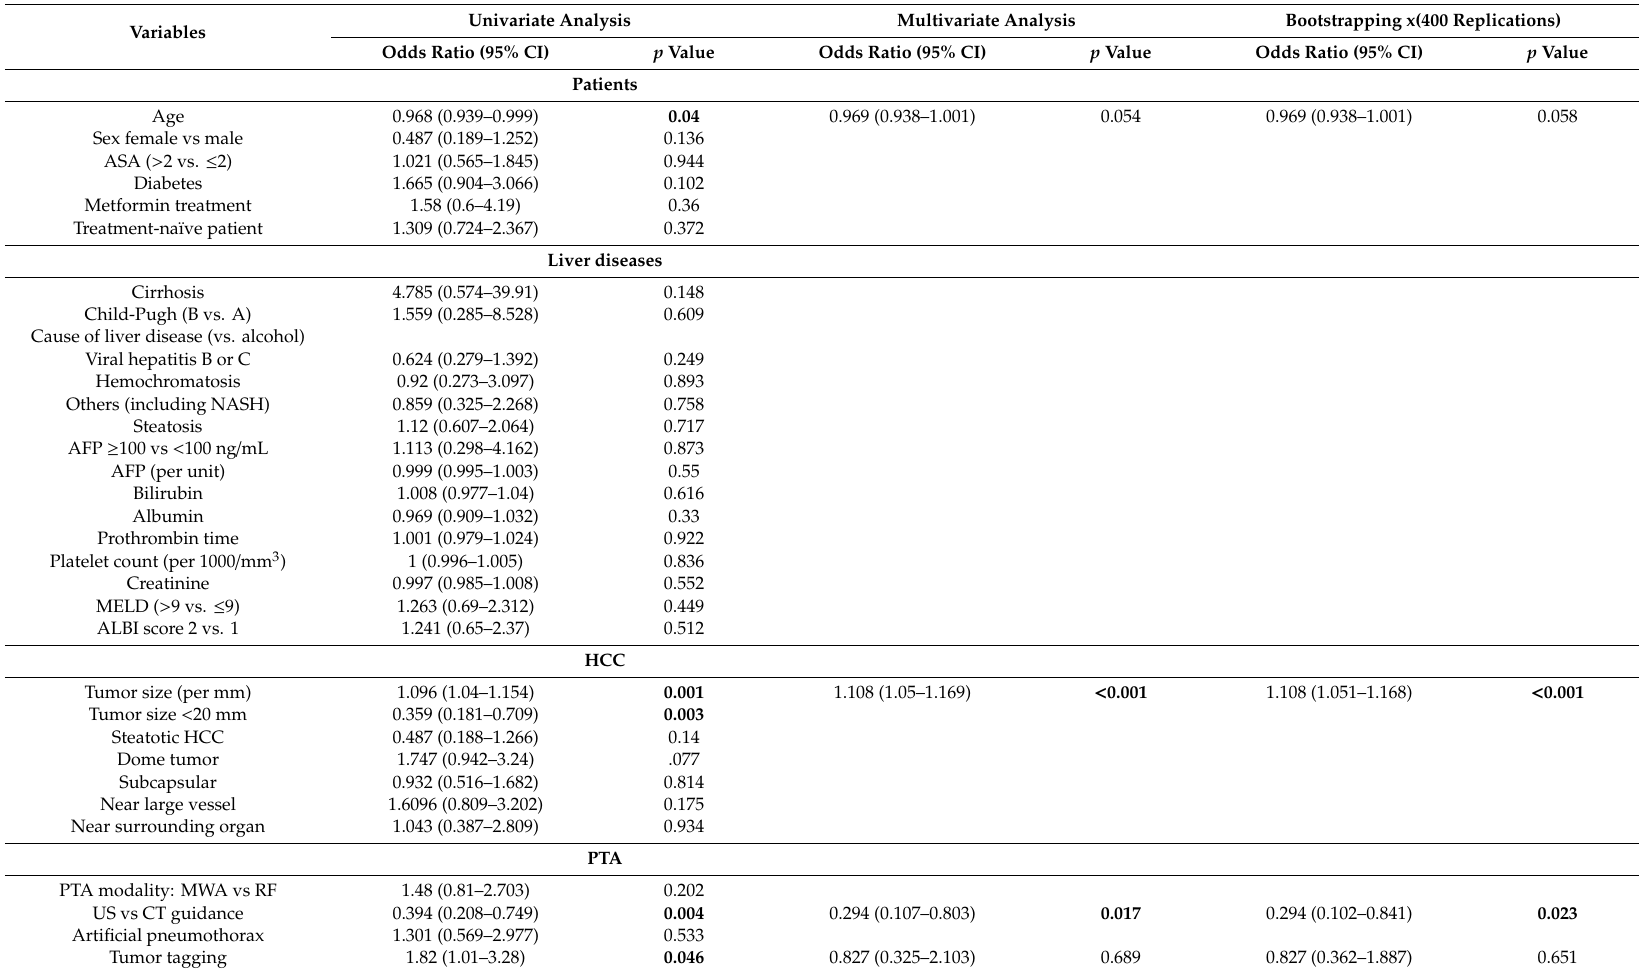
Table 2. Logistic regression analysis (generalized estimating equation (GEE) model) to predict local tumor progression (per tumor